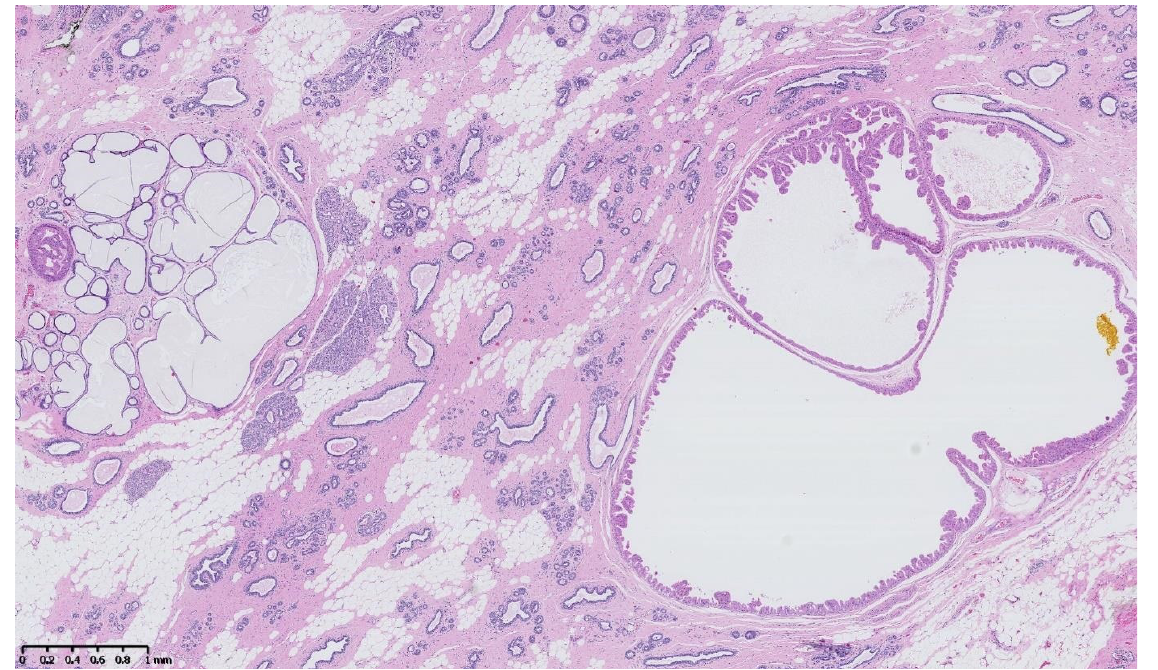
Figure 2. Hematoxylin and eosin staining: the surrounding breast parenchyma shows fibro-cystic changes with apocrine metaplasia, cystic ducts and usual duct hyperplasia.